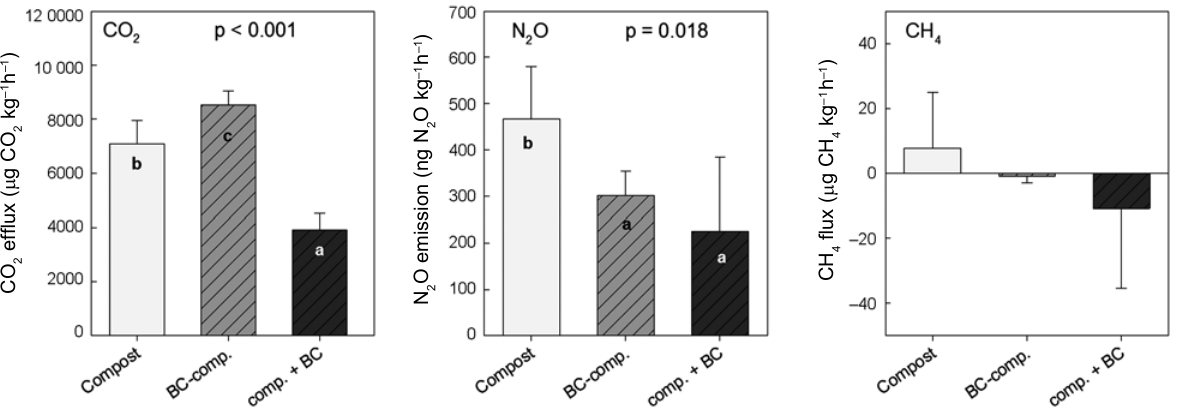
Fig. 2. Mean GHG flux rates of compost (comp), biochar-compost (BC-comp) and compost with later addition of fresh biochar (comp + BC), n = 5 + standard deviation; GHG flux measurements with 400 g substrate per 1-L Weck® jar as described in Kammann et al. (2012); Material properties and composting procedure described in Schmidt et al. (2014) and Kammann et al. (2015). Substrates were adjusted to 60% of their respective water-holding capacity one week before measurement. Letters indicate significant differences by one-way ANOVA (n = 5, p <